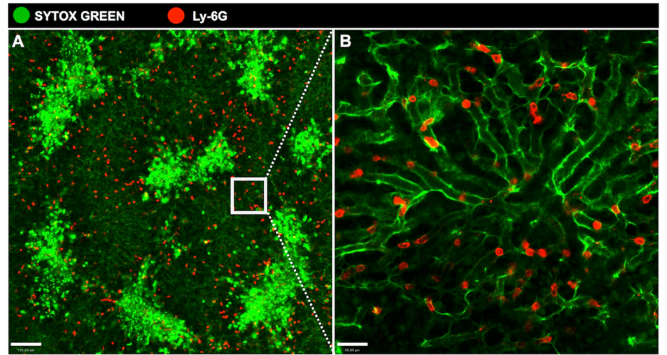
Figure 5. Accumulation of neutrophils in the hepatic sinusoids during acute liver